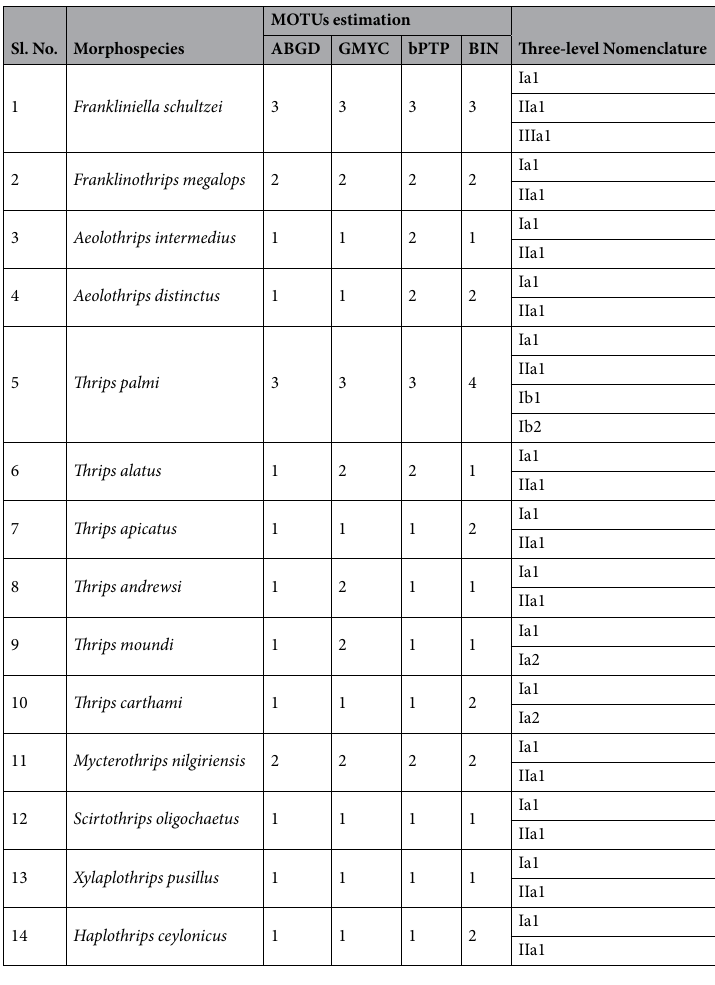
Table 2. Number of Molecular Operational Taxonomic Units (MOTUs) in 14 morphospecies detected by multiple automatic species delimitation methods and three-level